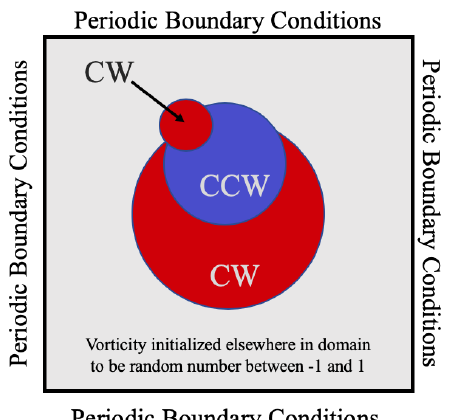
Figure A4. Illustrations of the boundary conditions and vorticity initialization for the cases of the bubble3 example.